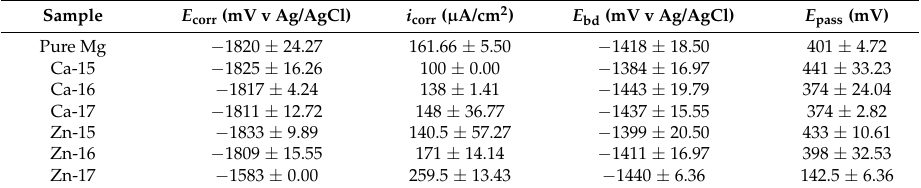
Table 4. Electrochemical results of Ca-ion and Zn-ion implanted magnesium in SBF.